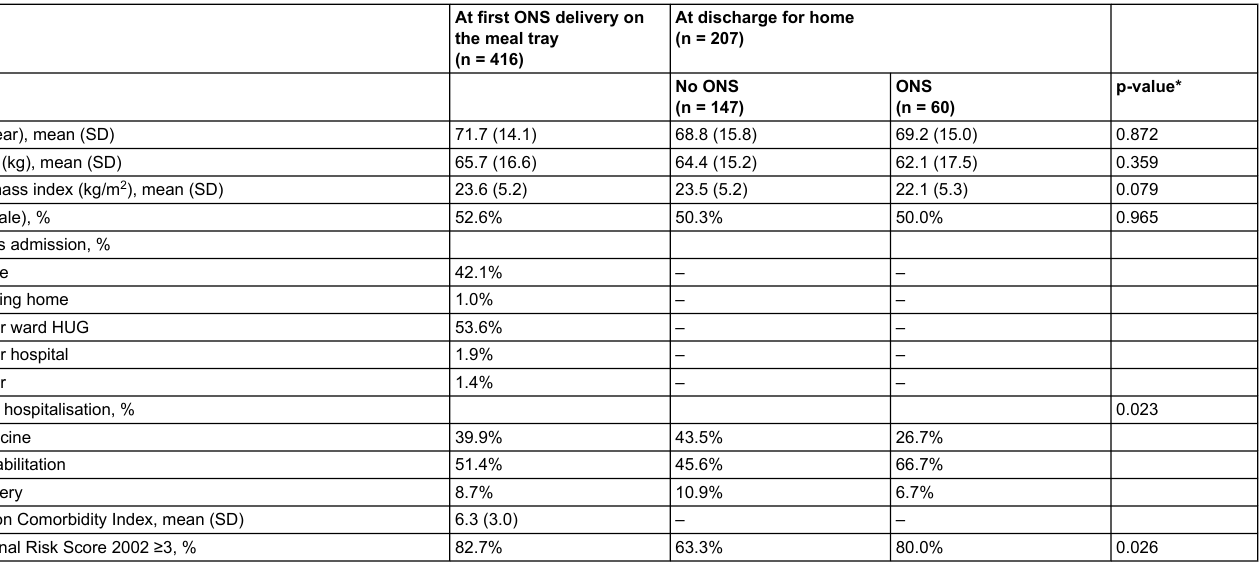
Table 1: Demographic and clinical characteristics in the